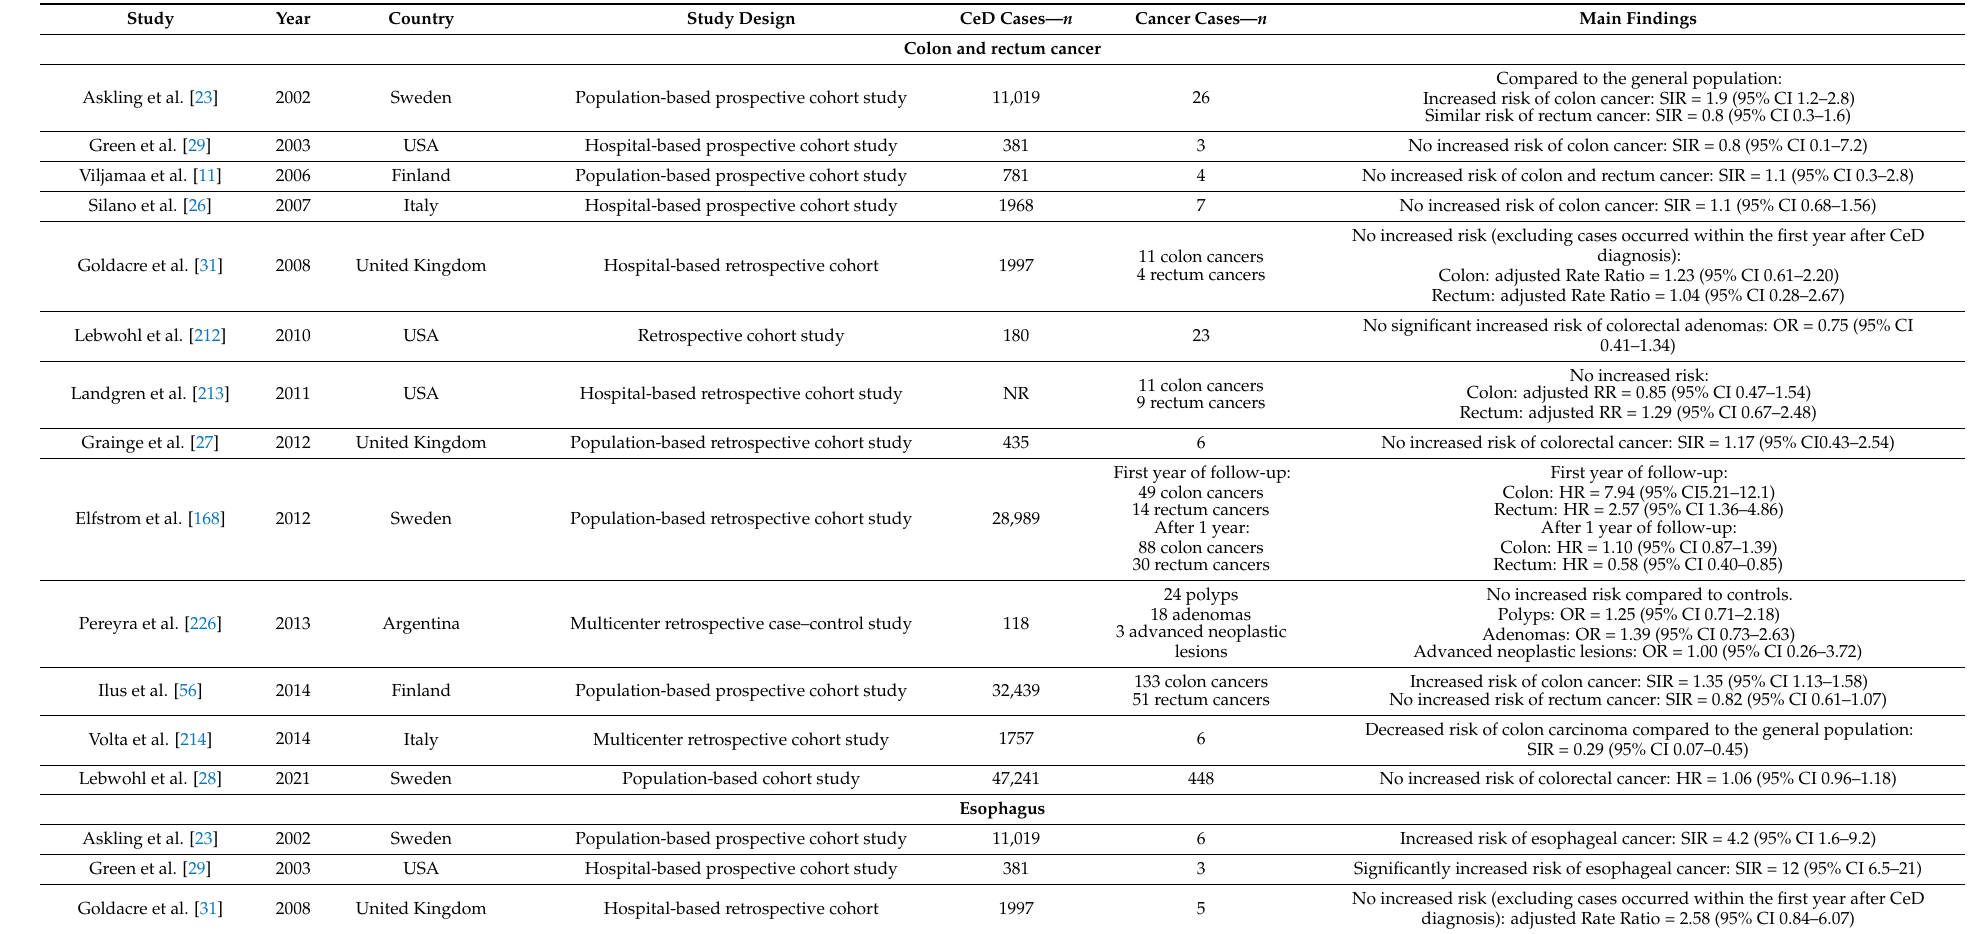
Table 4. Studies investigating the risk of developing several types of malignances in CeD